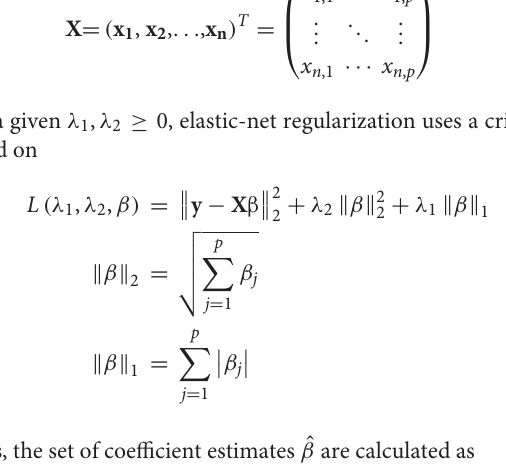
( Figure 2C ) and is calculated as D 3 = log S = { genomic locations with D 1 > 0 } and M = { genomic locations with D 2 > 0 }